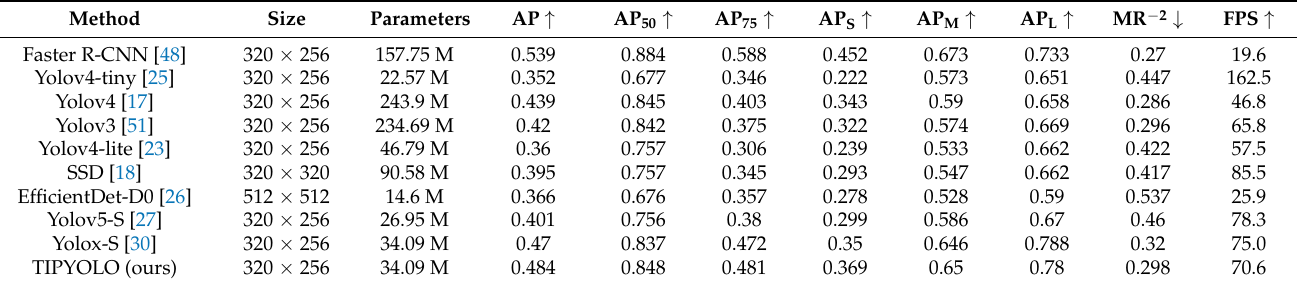
Table 4. The comparison results of the methods on the UTMD dataset. “ ↑ ” indicates that the larger the value, the better the performance; “ ↓ ” indicates that the smaller the value, the better the performance.